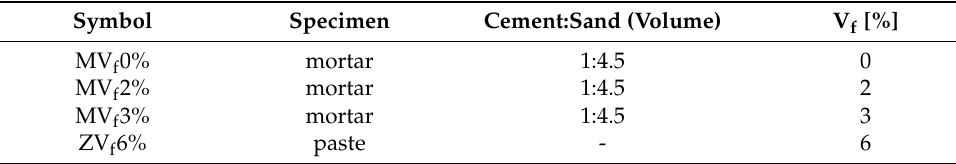
Table 1. Tested specimens.